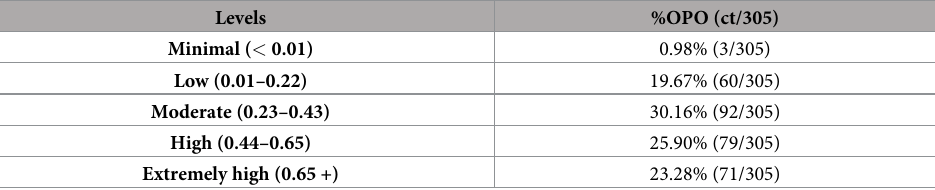
Table 2. Percentage of 305 OPO identified in each MaxEnt suitable feral pig habitat level. The final MaxEnt model contains a probability scale of 0.00 to 0.87 and was divided into equal